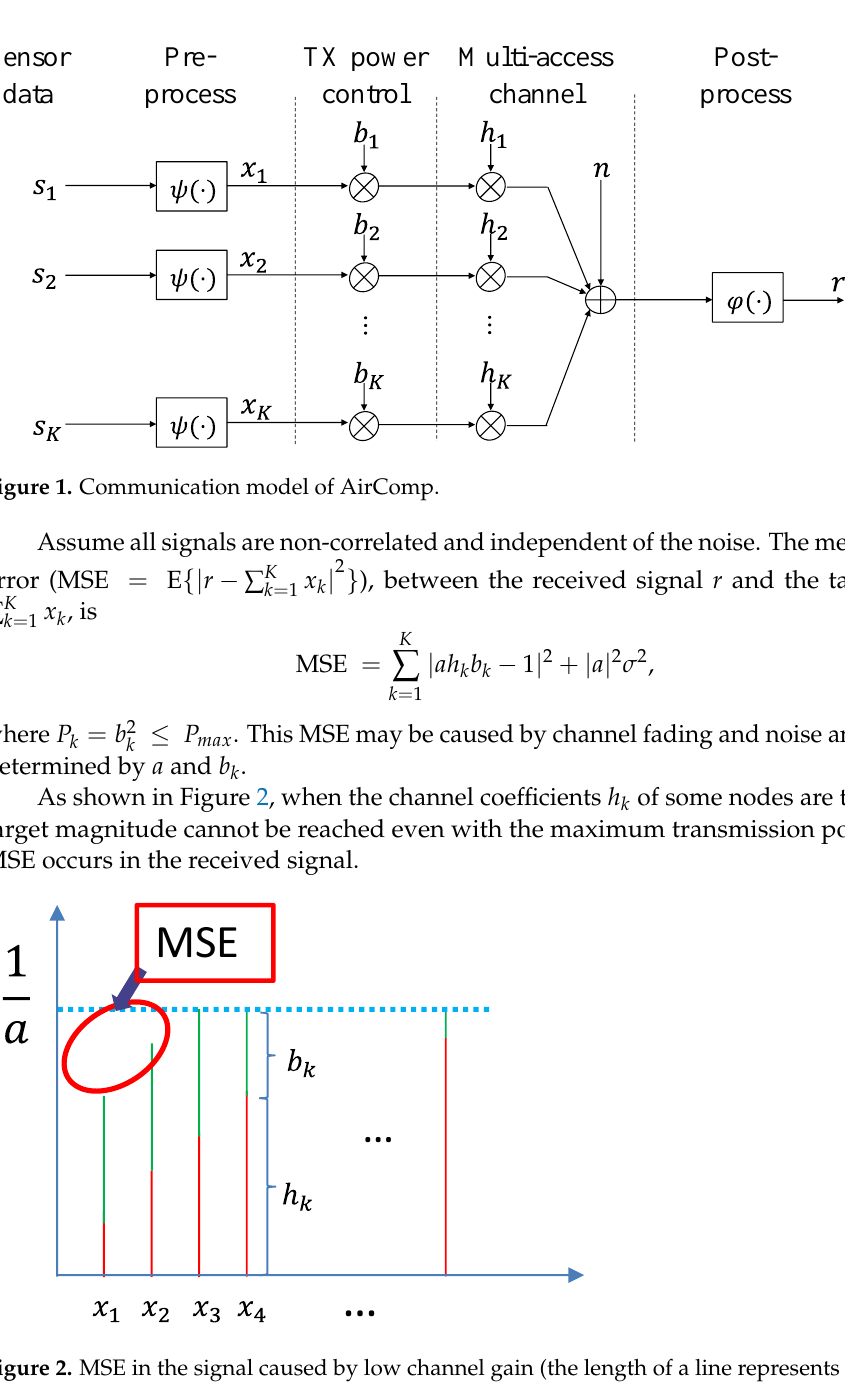
Figure 2. MSE in the signal caused by low channel gain (the length of a line represents the absolute value of a variable).